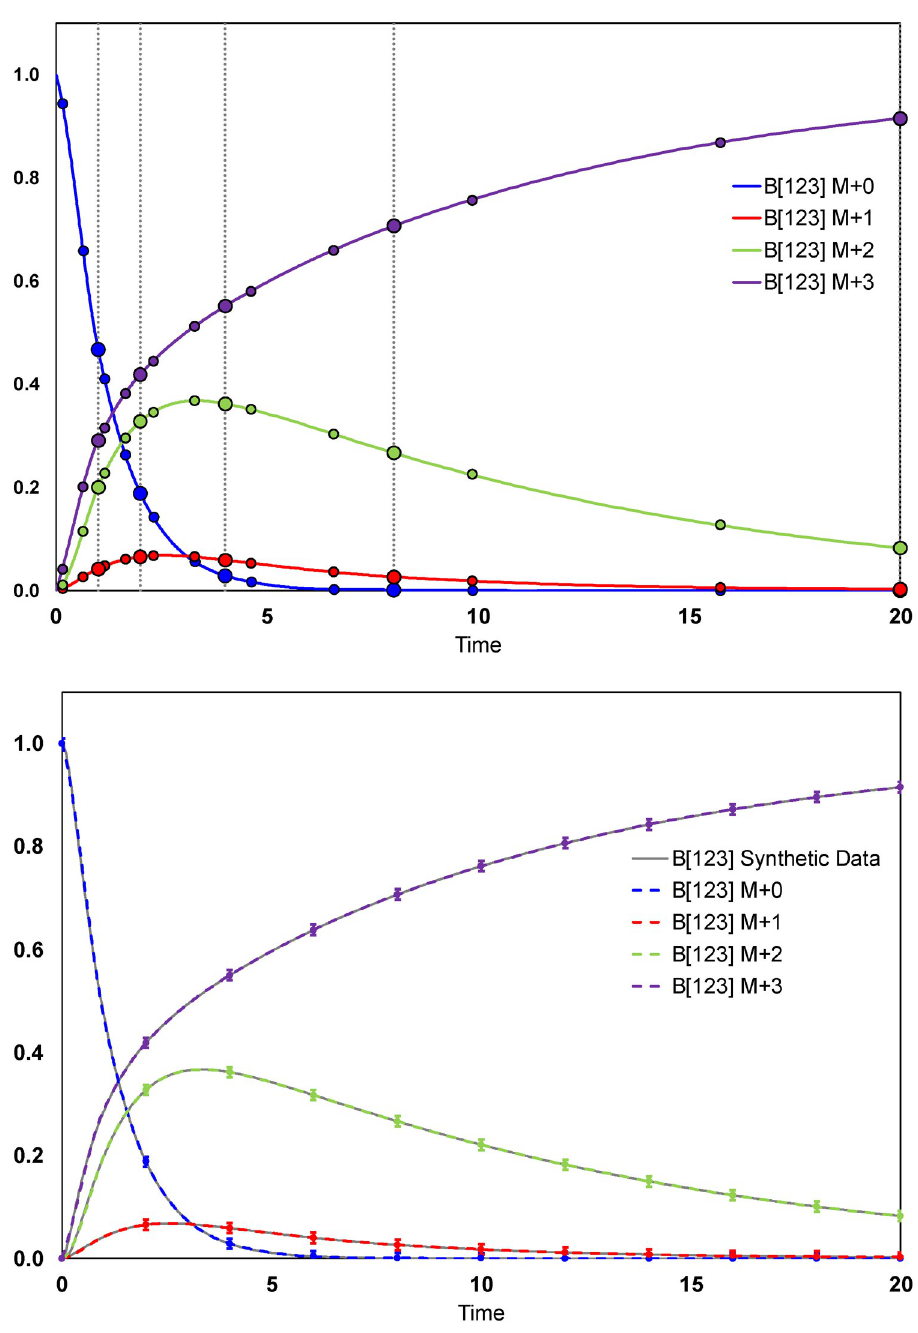
Fig 4. (Top) Continuous approximation to the DLS generated by fitting the synthetic measurements. The markers indicate the collocation points of the 5 th -order Radau IIA method, with the larger markers indicating the endpoint of each time interval (which are also collocation points in Radau IIA methods). The vertical dashed lines indicate the boundaries of each time interval. (Bottom) The fit to the synthetic data is shown, with a standard deviation of 0.01 arbitrarily assigned to each synthetic measurement. The synthetic data was generated by numerically solving the cumomer balances with a known flux and pool size distribution using the 4 th -order explicit Runge-Kutta method and a time step of 0.02. The continuous approximation generated by the 5 th -order Radau IIA collocation method fitting the synthetic measurements is superimposed for comparison. Clearly, using the collocation method the synthetic measurements are accurately fit by the model, and the continuous approximation accurately matches the synthetic